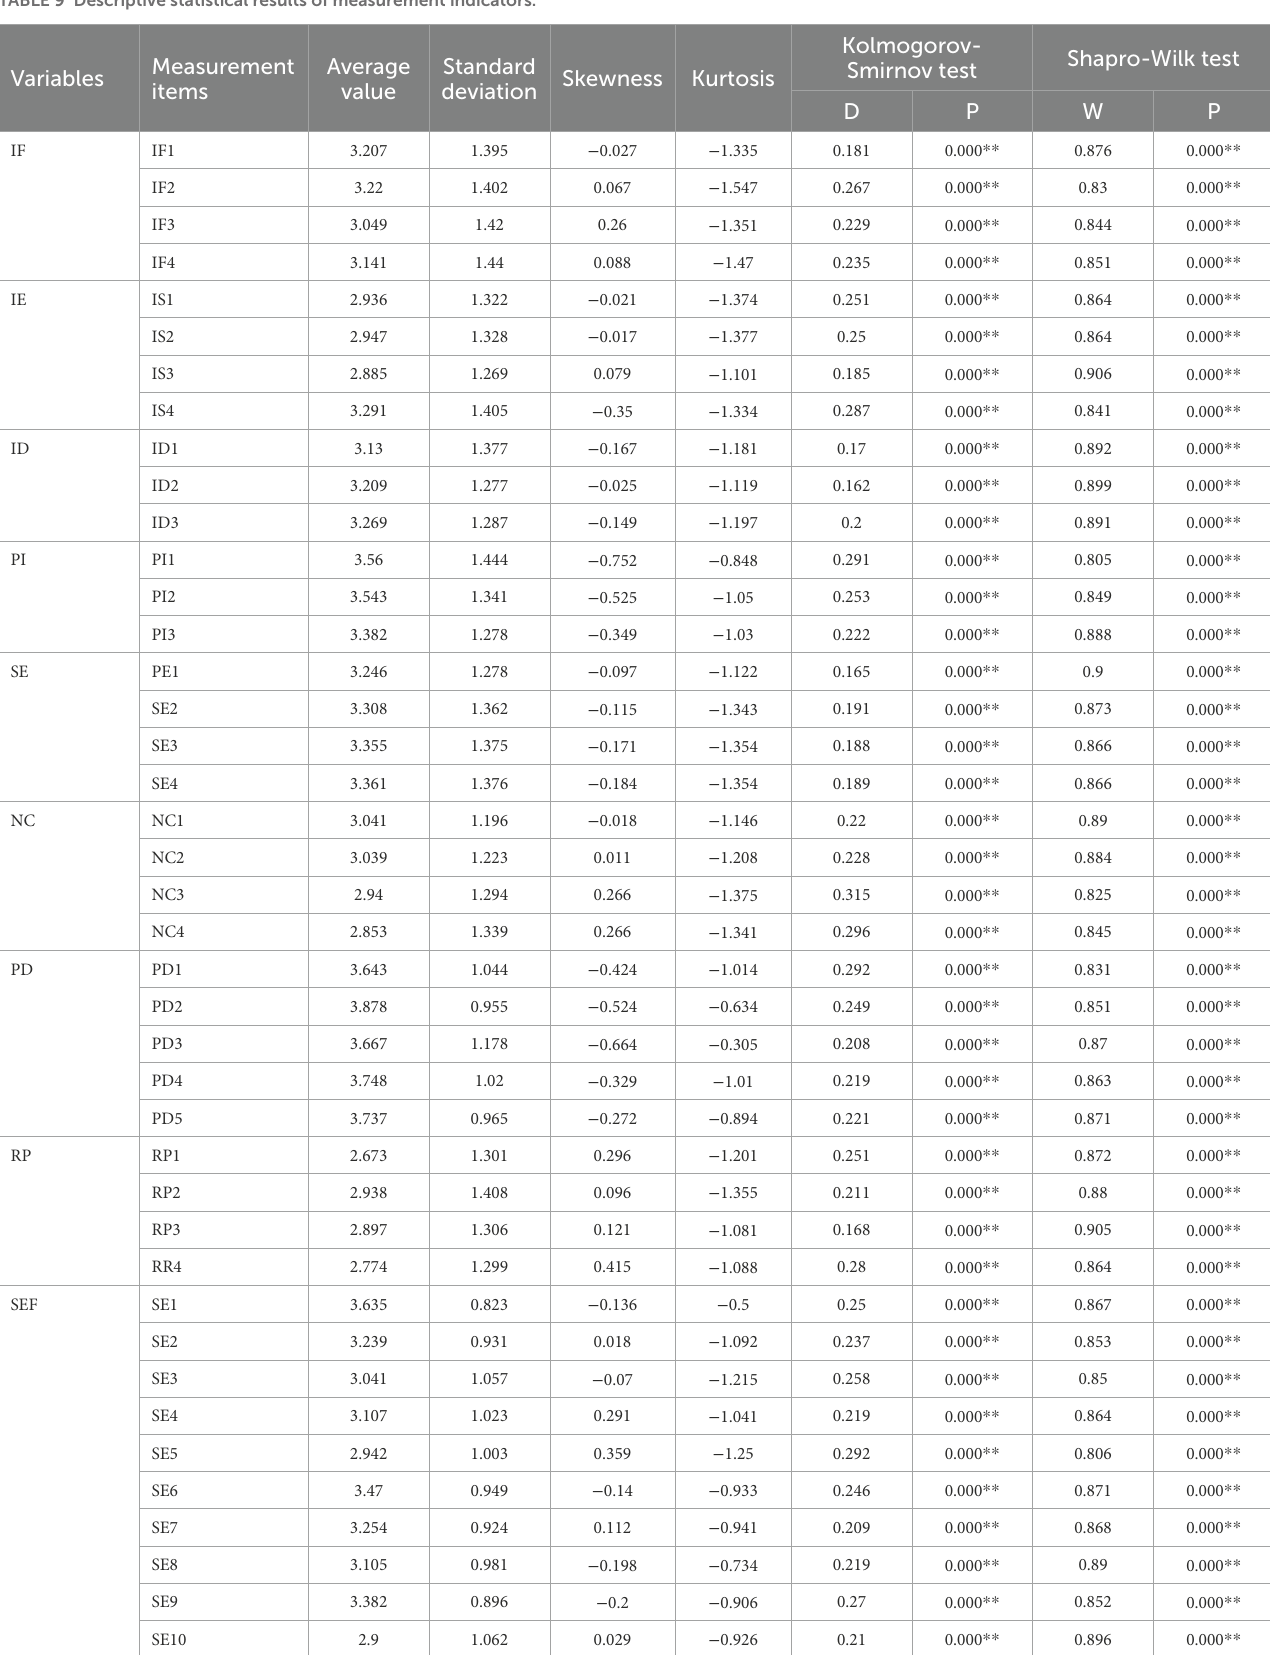
TABLE 9 Descriptive statistical results of measurement indicators.